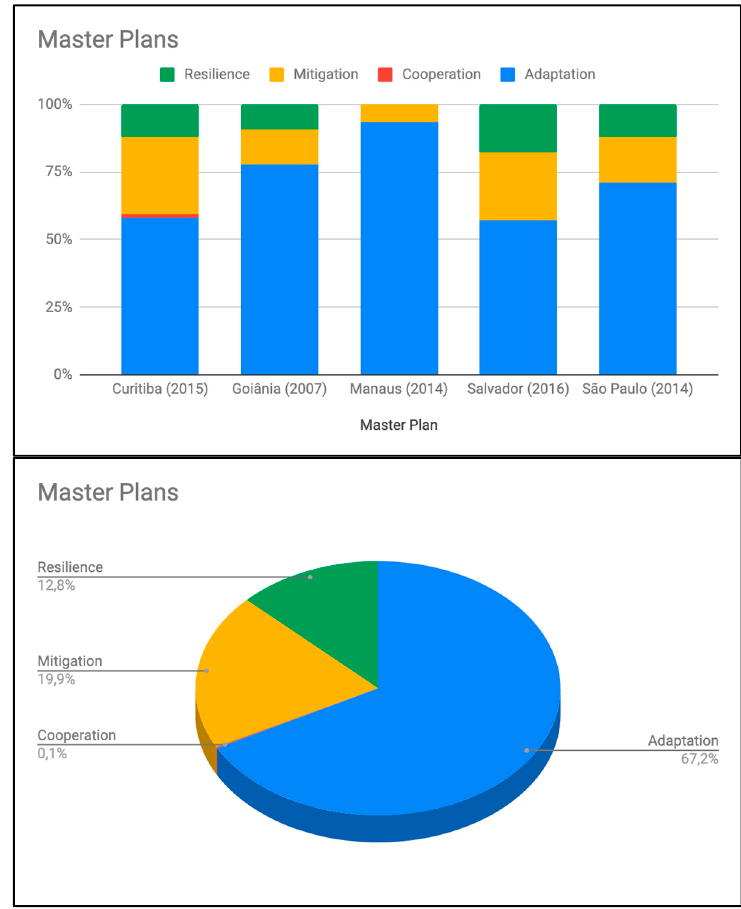
Figure 8. Climate action references in master plans.